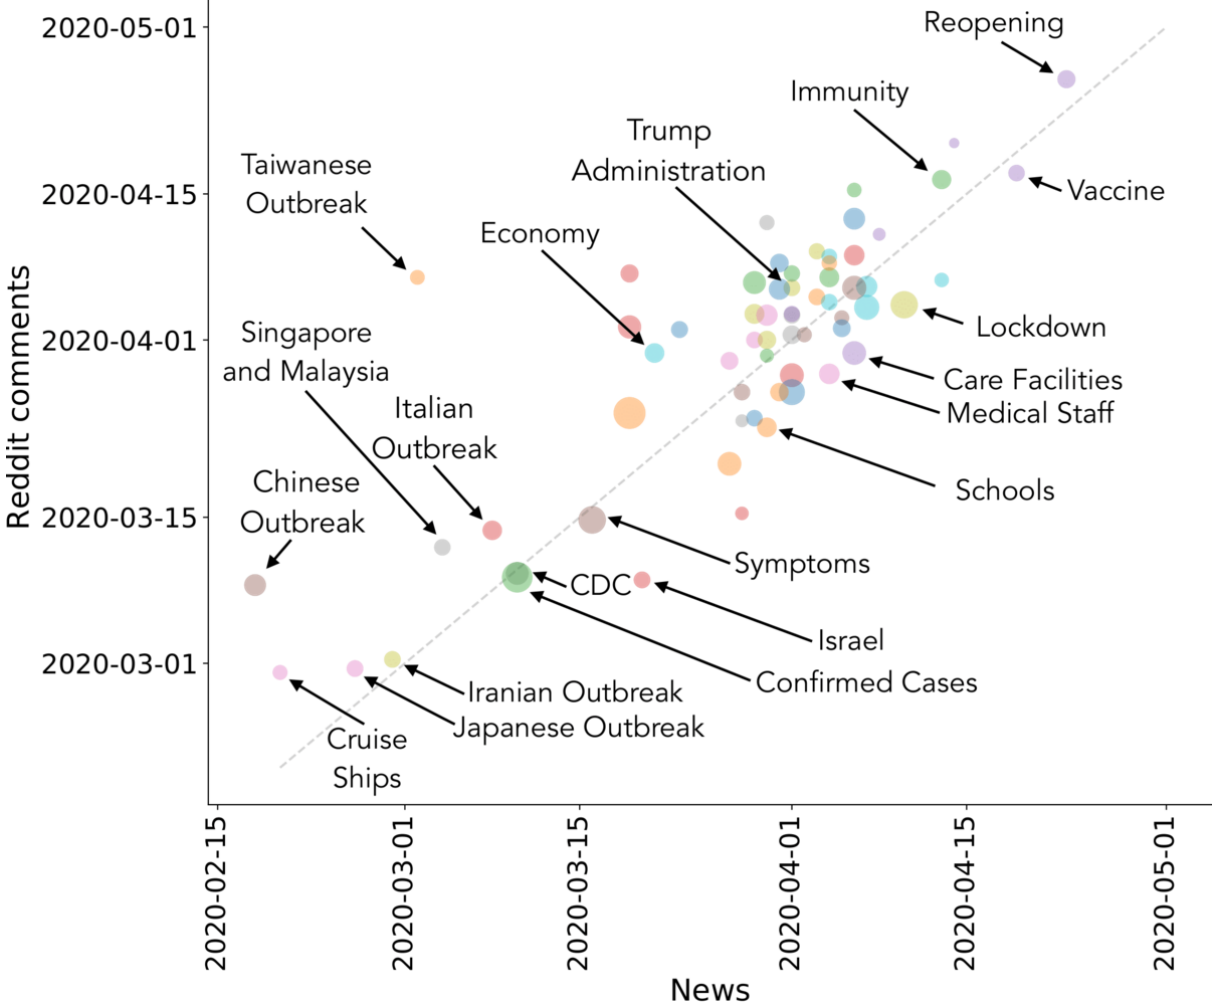
Figure 4. Scatter plot with the 64 topics extracted via nonnegative matrix factorization. The x-axis and y-axis coordinates indicate when a topic achieved 50% of its relevance in news outlets and on Reddit, respectively, during our analysis interval. CDC: US Centers for Disease Control and